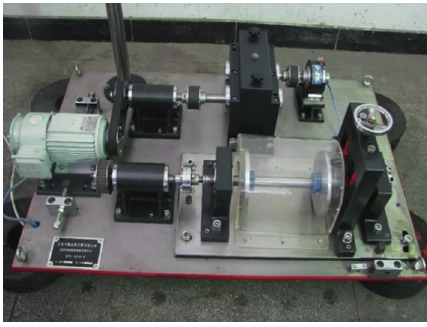
Figure 6: The fault diagnosis test platform for rotating